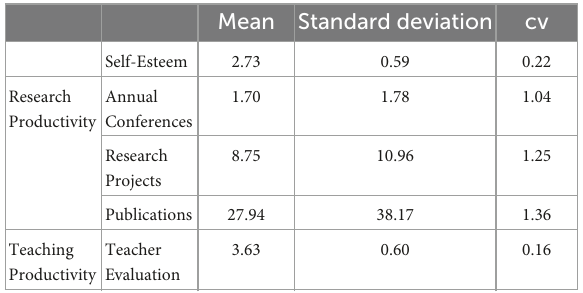
TABLE 2 Descriptive statistics of the variables.